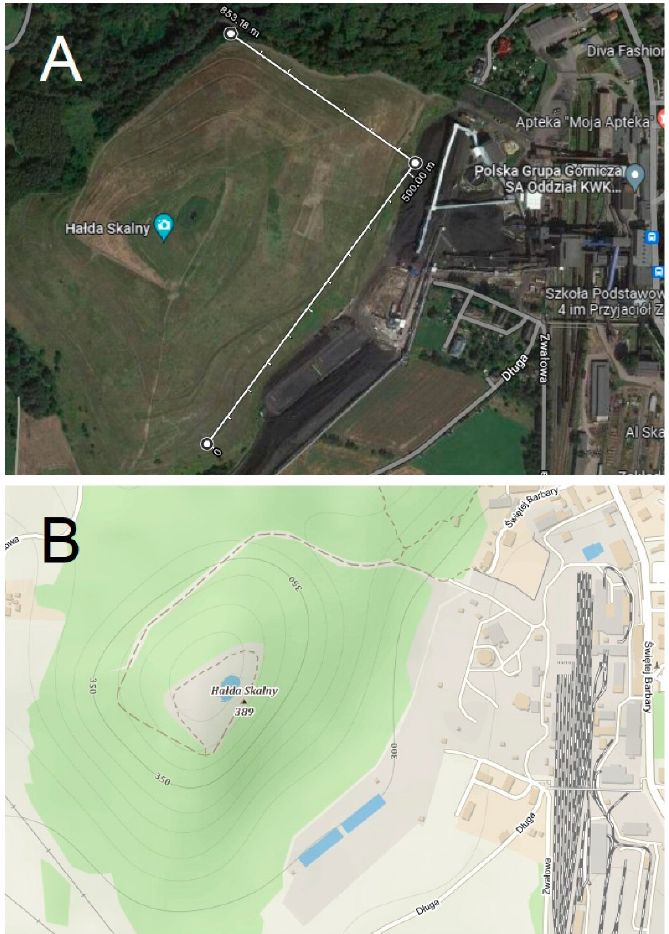
Figure 7. Map of “Ha ł da Skalny” coal waste heaps ( Ł aziska Górne, Silesia, Poland). ( A )—satellite view (source: Google Maps), ( B )—topographic view (source: openstreetmap.org, Open Database License).